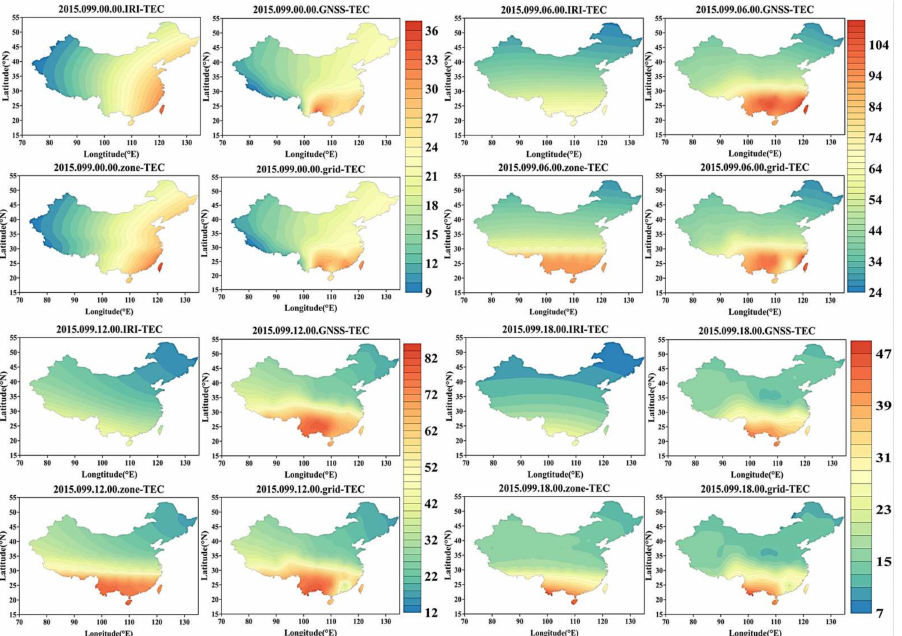
Figure 5. 2-D distributions of GNSS-TEC, the TEC estimates calculated using the original IRI-2016 model, and the TEC estimates obtained using schemes A and B in the parts of China region at the four time points of 0, 6, 12, and 18 UT on April 9 (DOY099) 2015.